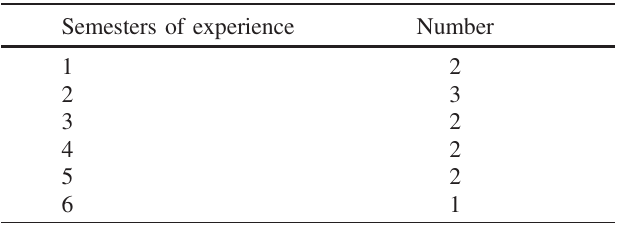
TABLE IV. Semesters of experience teaching in P Cubed of the learning assistants